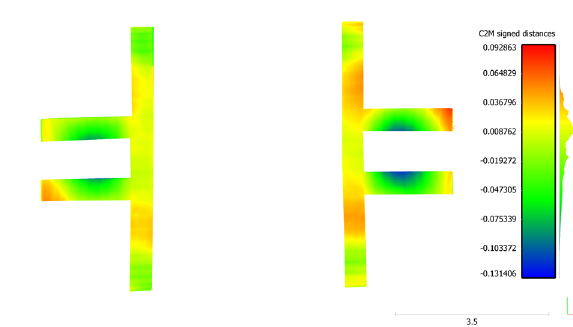
Figure 15 . 3D model view of independent arches realized in Grasshopper (Processing: F.